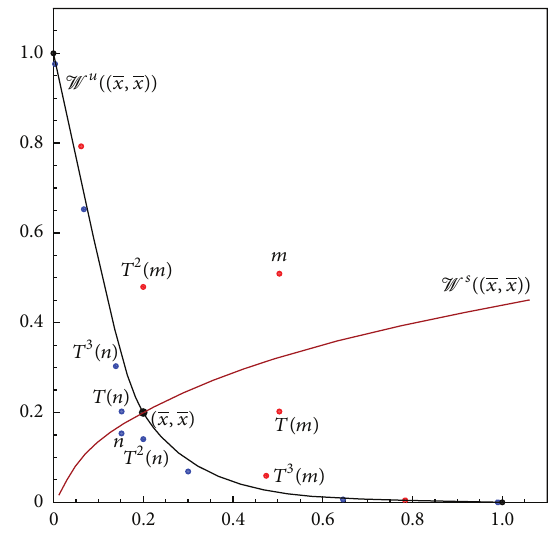
Figure 1: Global dynamics of (1) for 𝑎 = 1 , 𝑏 = 1 , and 𝑐 = 5 —an illustration of Theorem 12.